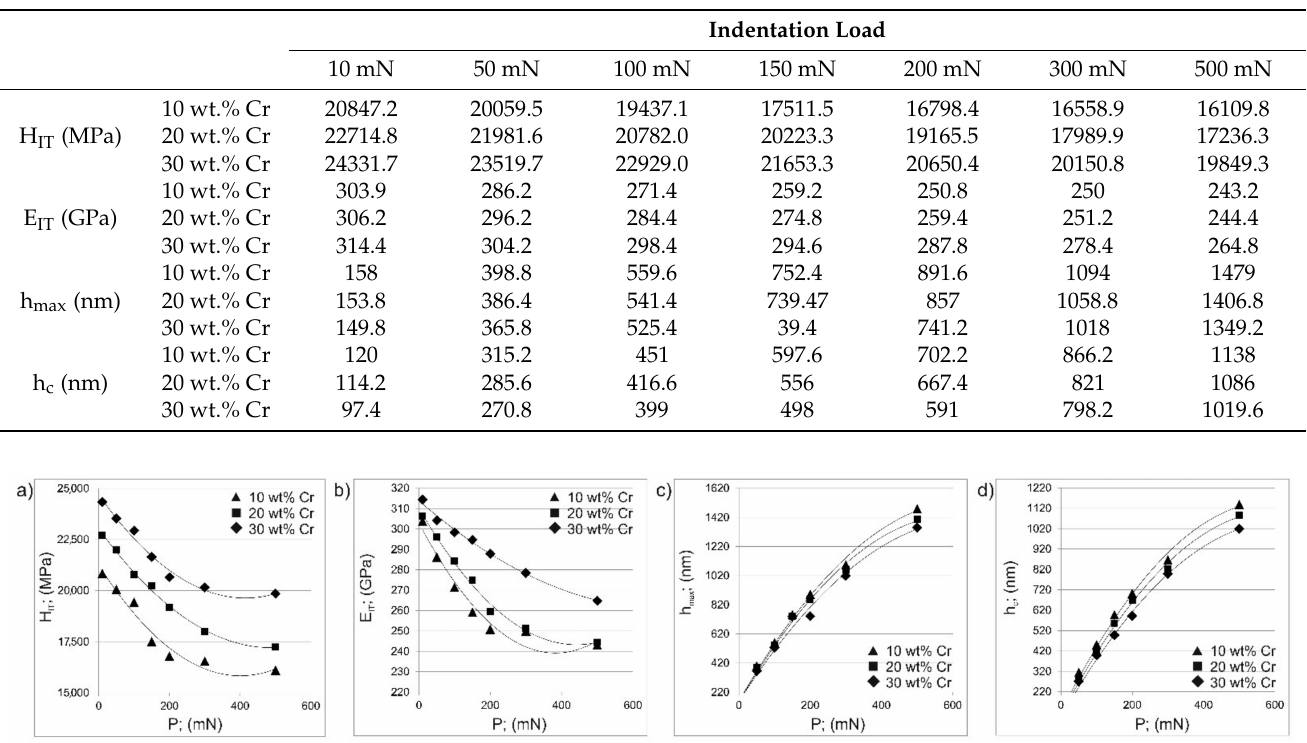
Figure 6. Dependence of the indentation hardness H IT ( a ), indentation elastic modulus E IT ( b ), maximum penetration depth h max ( c ) and contact depth of the indenter with the sample at maximum load h c ( d ) on the indentation load P obtained for testing areas differing in the concentration of